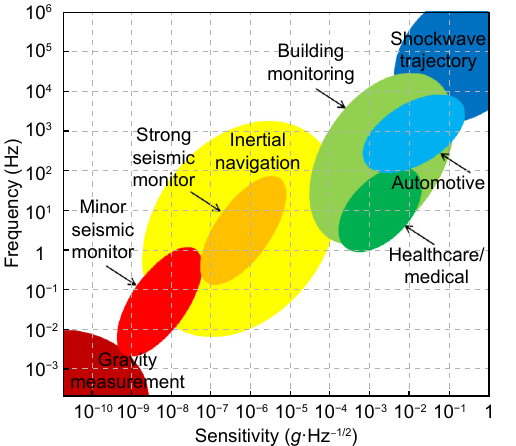
Fig. 1 | Typical specifications of potential application scenarios of MOEMS